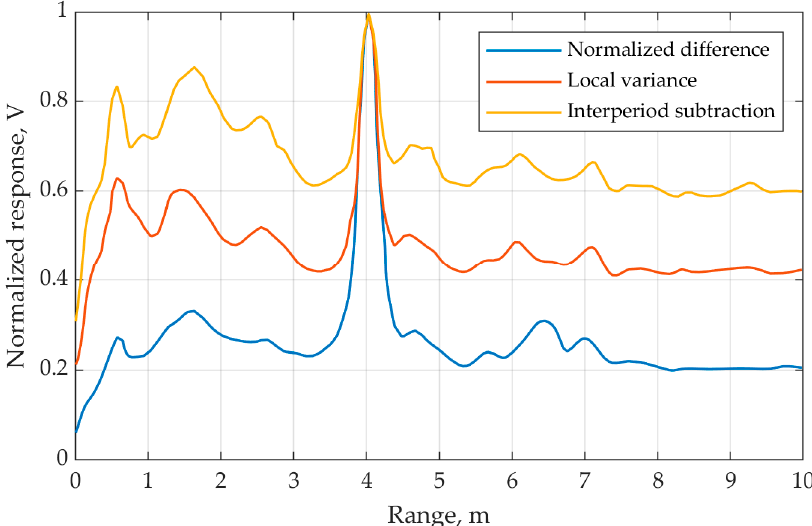
Figure 8. The values of statistics accumulated for 400 frames depending on the range when using the basic interperiod subtraction algorithm (yellow line), local variance algorithm (red line), normalized difference samples algorithm (blue line).